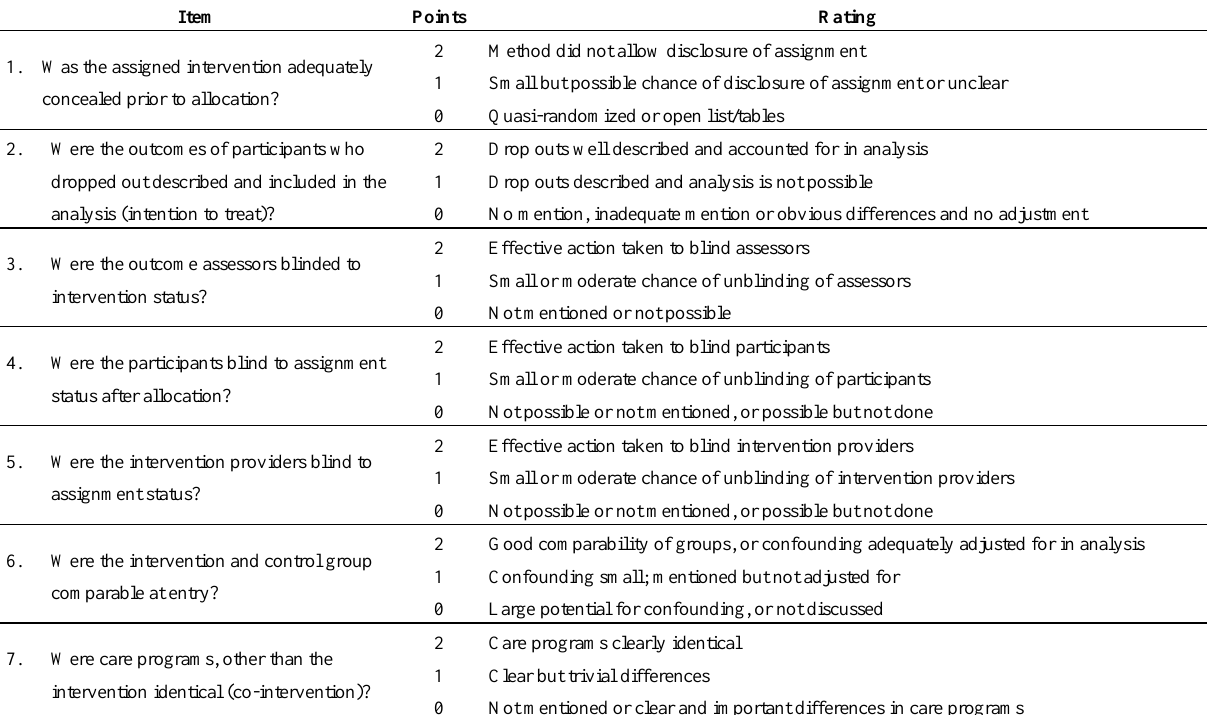
Table A1. Quality rating (internal